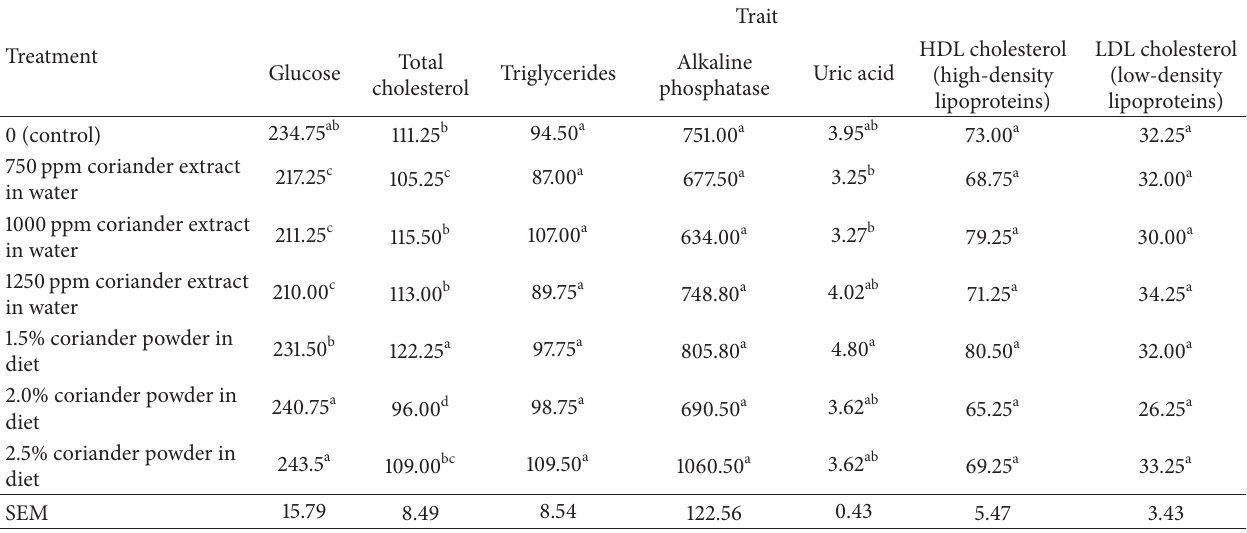
Table 7: Hematological parameters mean ( ± SEM) of Ross 308 broilers fed diets or water containing the different levels of coriander ( Coriandrum sativum L.) powder and extract at 42 days of age (mg/dL) a,b,c,d .